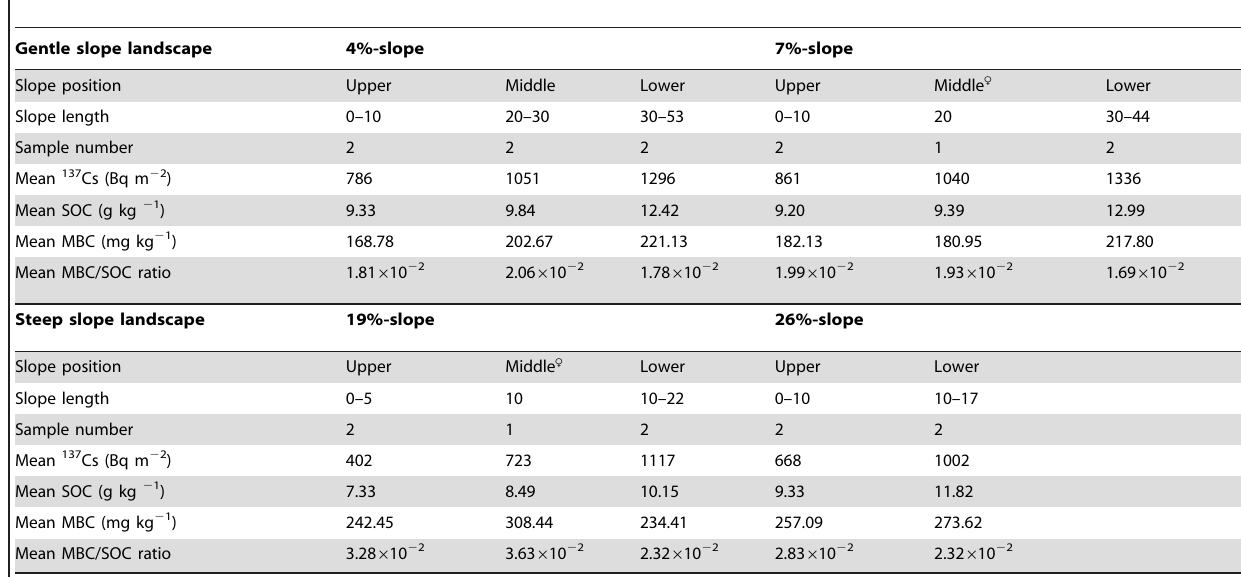
Table 2. Descriptive statistics of 137 Cs inventories, SOC and MBC contents in different positions for gentle and steep slope landscapes.